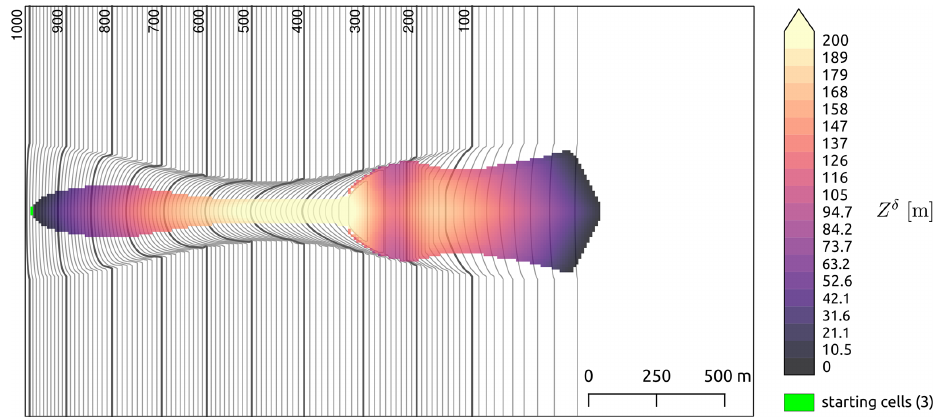
Figure 5. GMF runout modeled with Flow-Py on a parabolic slope with a channel and a dam that crosses the terrain at 1350m with α = 25 ◦ , = 8849m. The colors show the value of Z δ exp = 8, R stop = 3 × 10 − 4 , and Z δ max , which is associated with maximum kinetic energy. The lim topography is a simple parabolic slope connected to a flat plane.